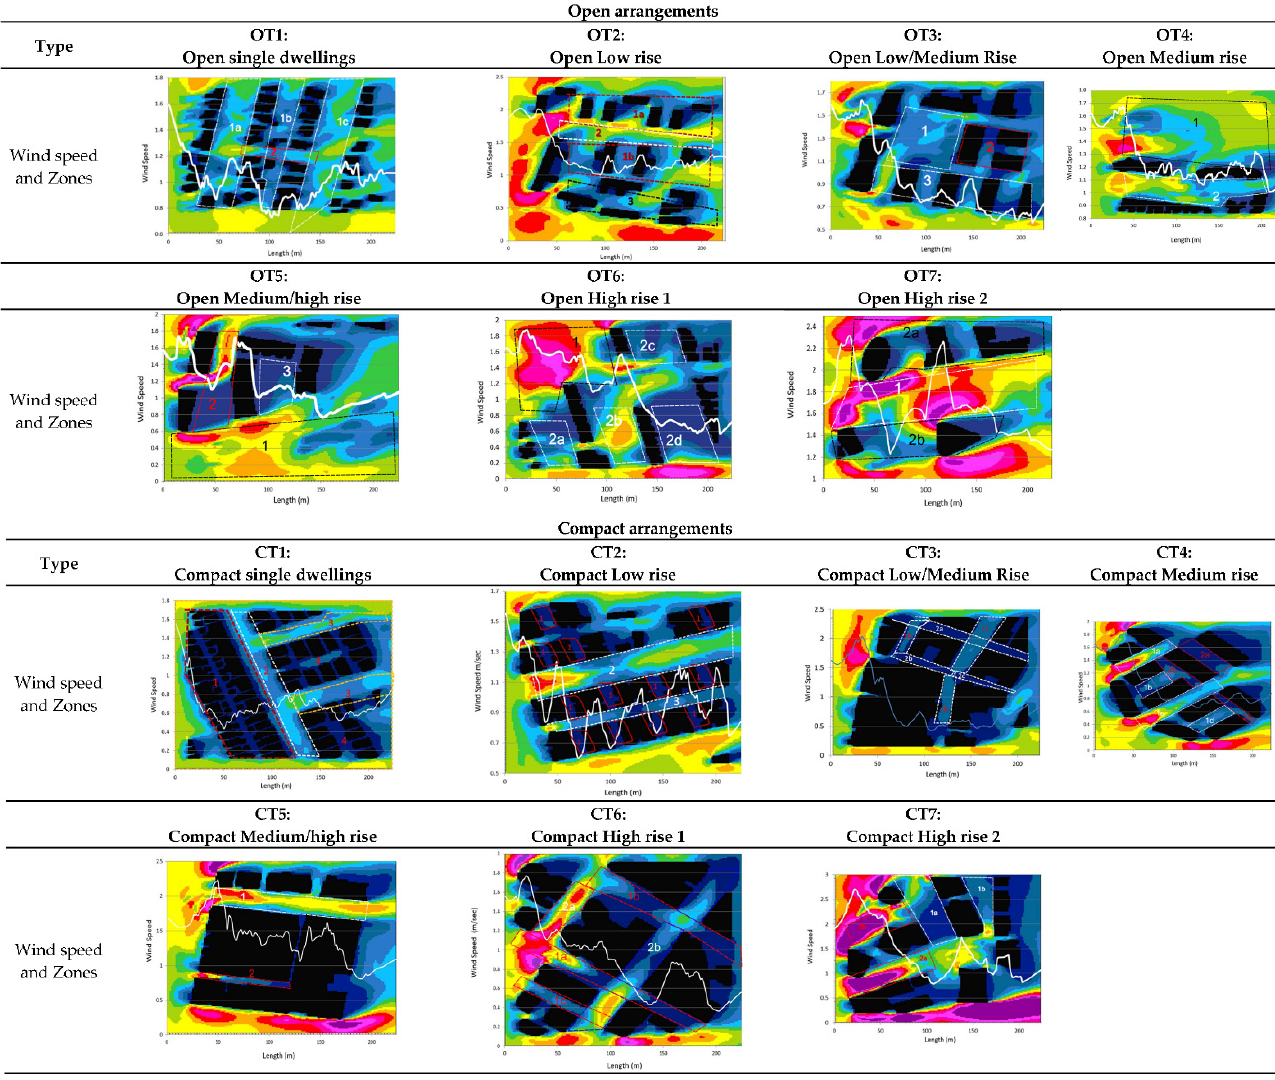
Figure 9. Wind speed in all precincts.